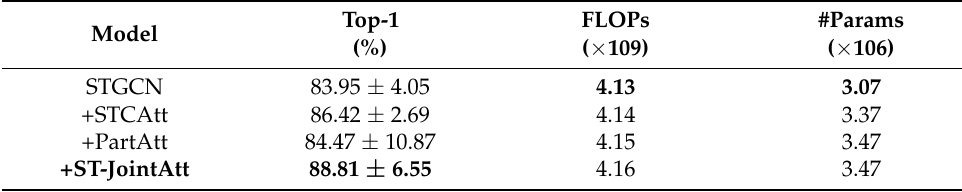
Table 3. Comparison of different attention modules.